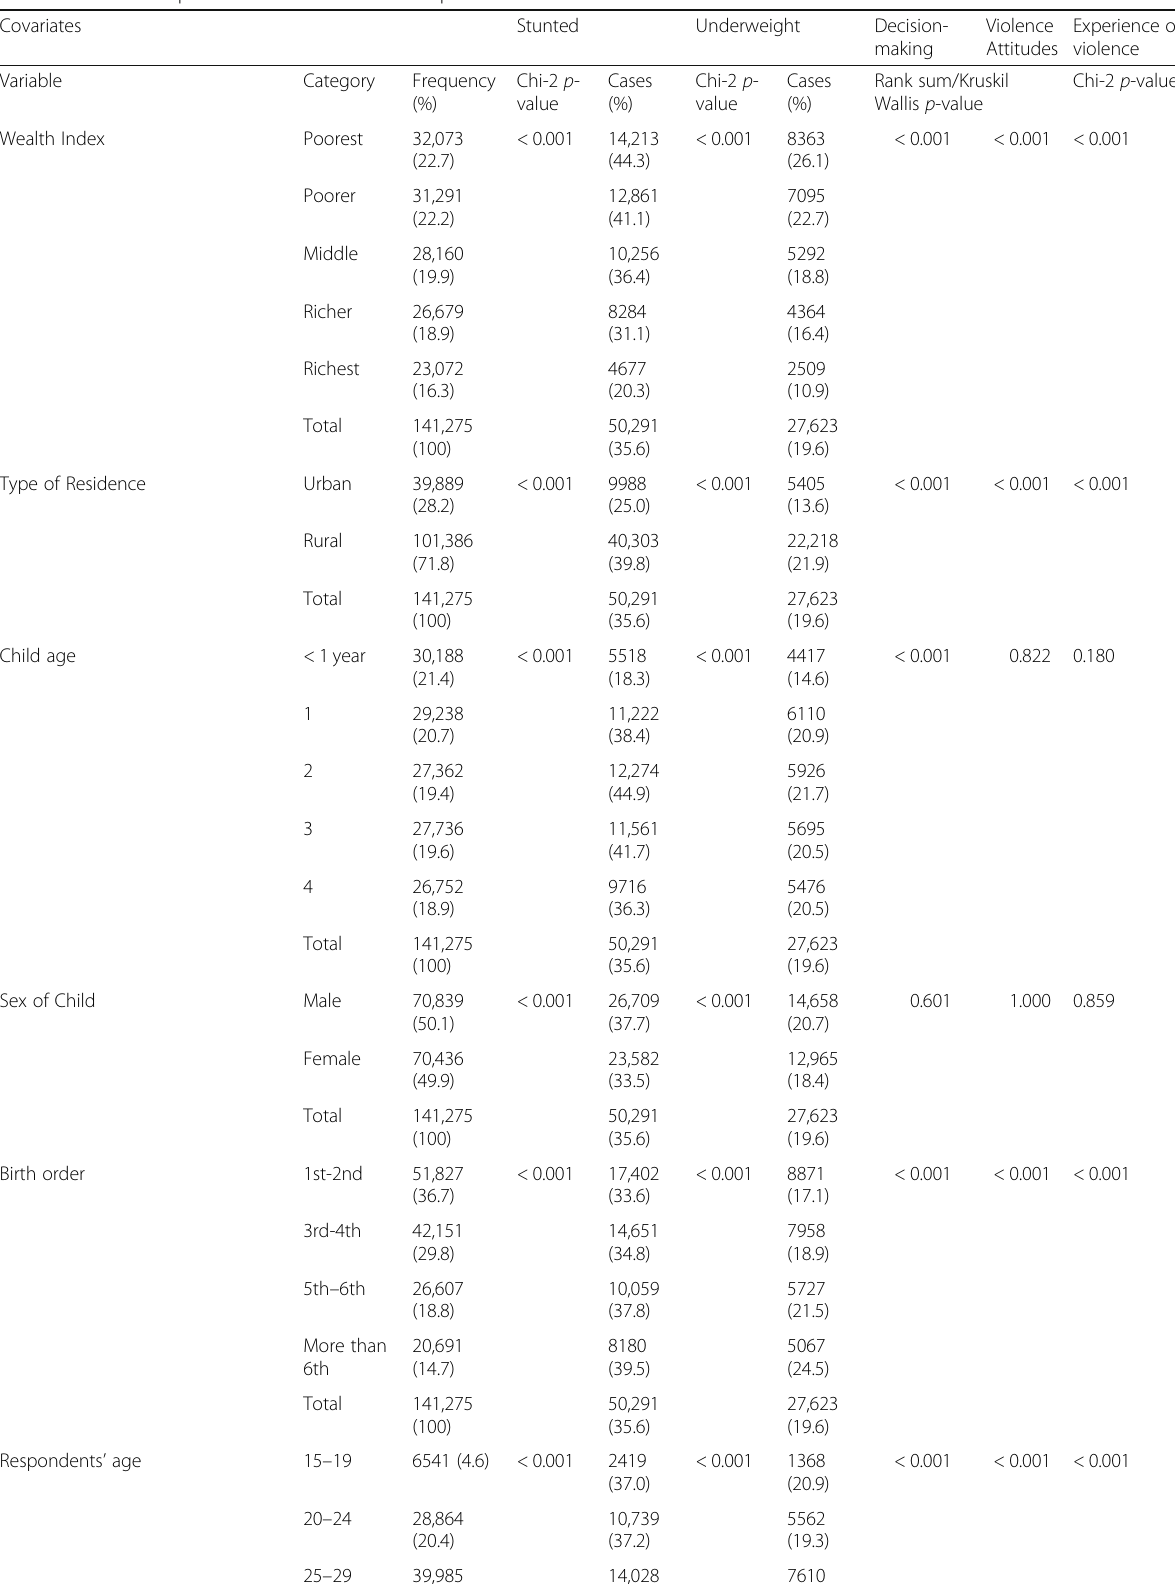
Table 3 Relationship between outcomes and Exposures with Covariates Covariates Stunted